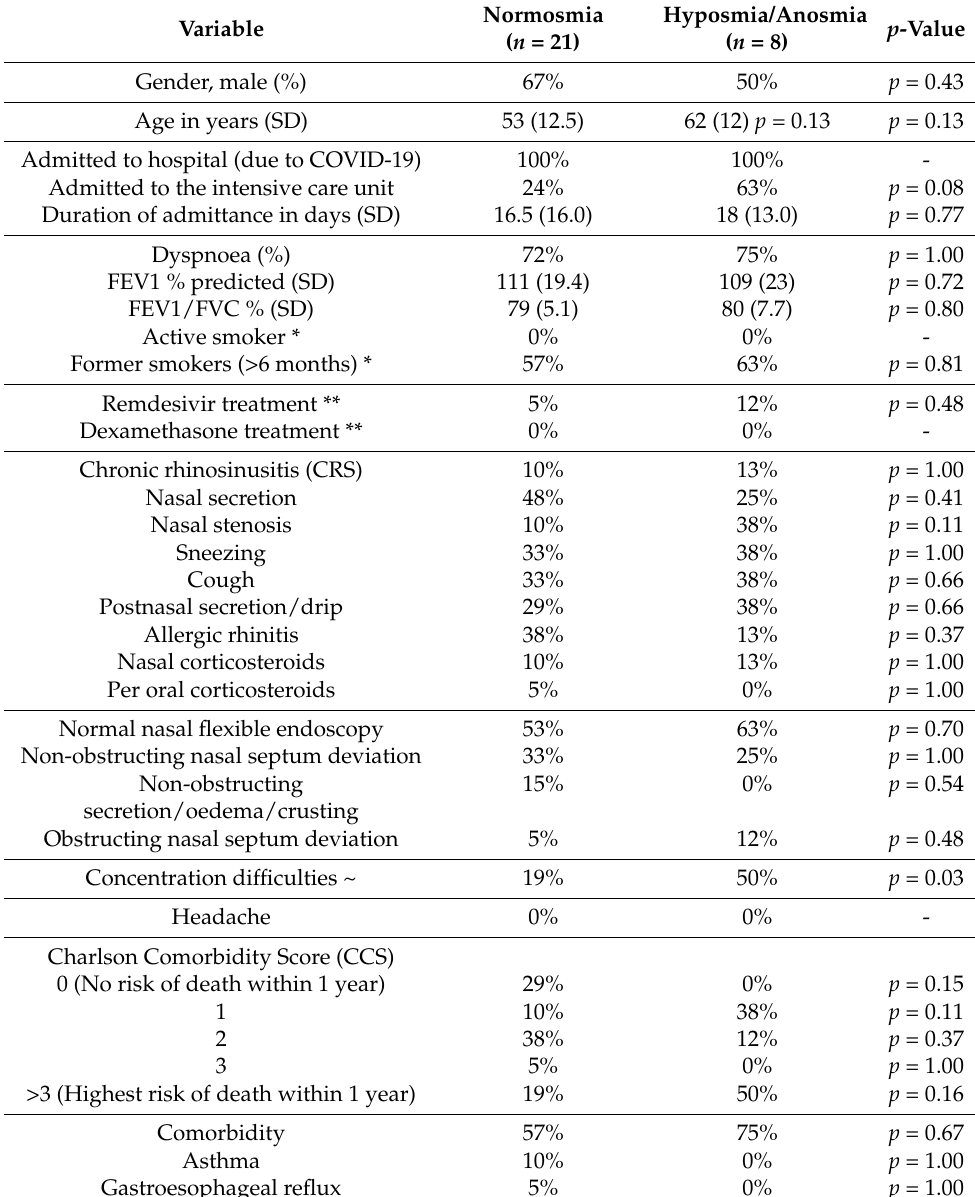
Table 1. Patient demographics 3–6 months after hospitalisation for COVID-19 stratified according to psychophysical olfactory test (Threshold, Discrimination, and Identification)